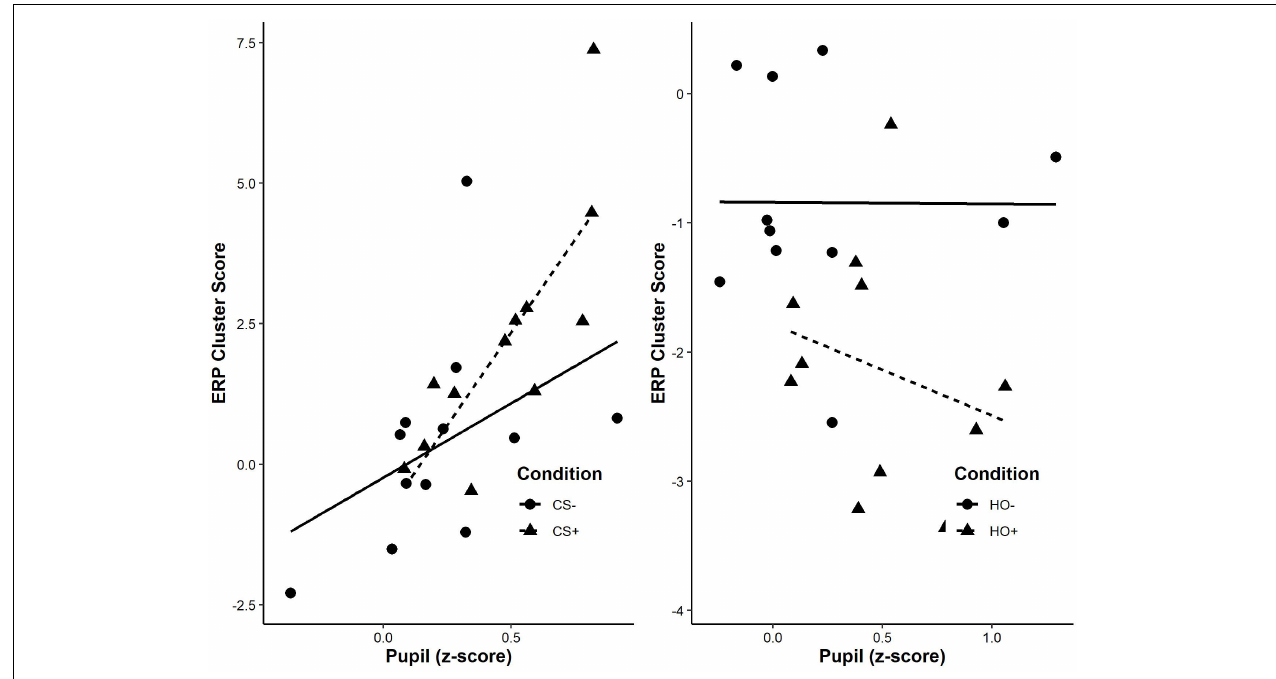
FIGURE 4 | Correlation of mean pupil z -score and ERP cluster score for each participant comparing the valence of the effect (+: aversive represented by triangles; –: neutral represented by circles) for first-order (left) and higher-order stimuli (right). A significant positive correlation between mean pupil dilation z-score during the maximal CS+/CS − difference (1050–2700 ms) and the significant cluster from the bootstrap analysis of evoked responses (240–300 ms) for CS+, r (12) = 0.643, p = 0.002, but not CS − , r (12) = 0.419, p = 0.175. No such correlation was detected in response to higher-order